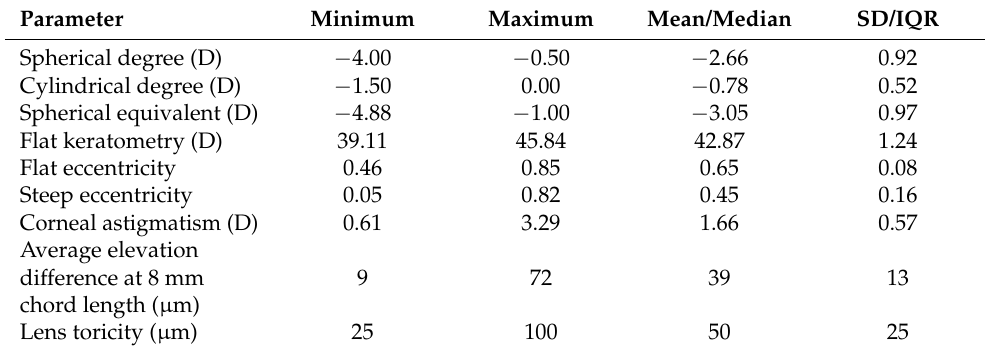
Table 1. Baseline ocular biometrics and lens